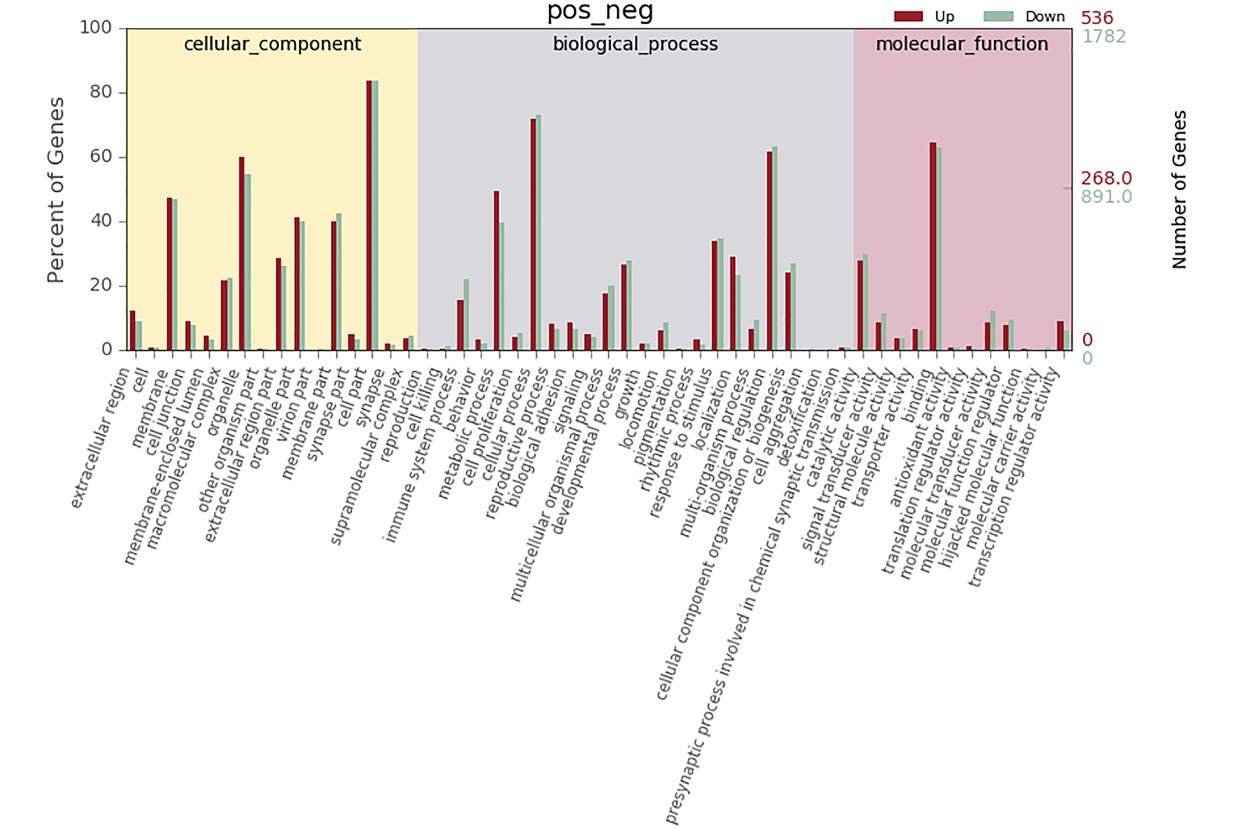
FIGURE 8 | GO analysis of microRNA in MM. The significant molecular function, biological process, and cellular component changed mRNA-targeted ncRNAs in MM. Statistics of DE gene annotation results in GO entries. The abscissa is the second-level GO entry in the DE gene annotation results, the left ordinate is the proportion of upregulated/downregulated DE genes, and the right ordinate is the number of upregulated/downregulated DE